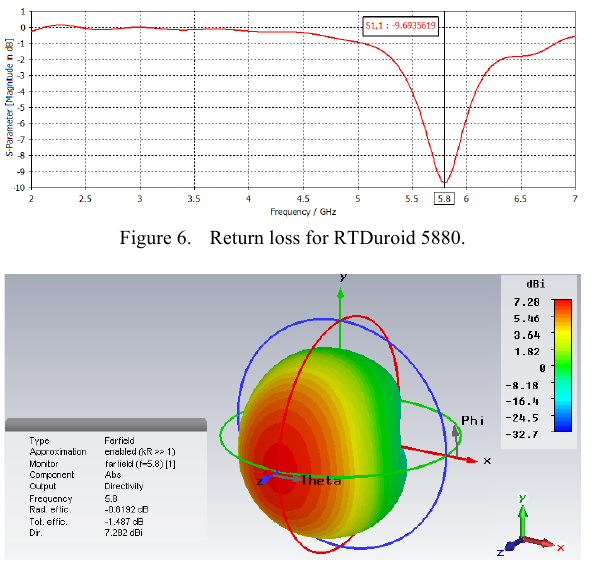
Figure 7. Far field region for RTDuroid 5880.